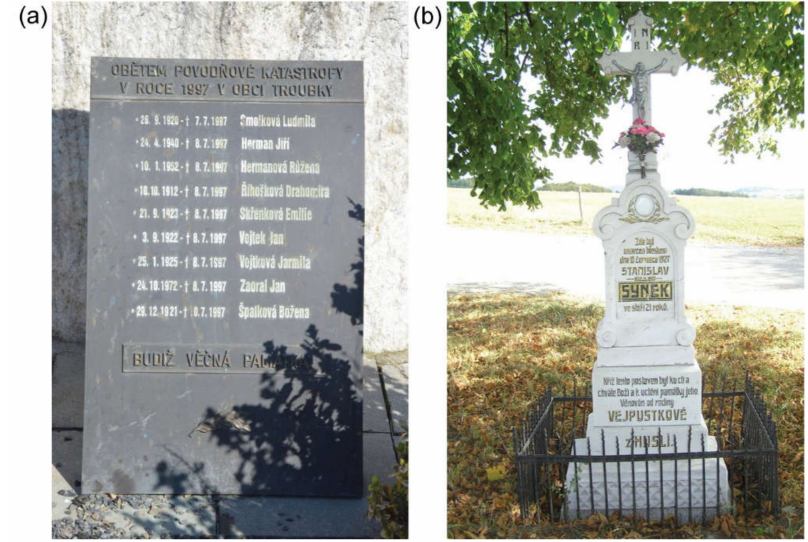
Figure 3. Examples of epigraphic evidence: ( a ) a list of victims of the July 1997 flood on the memorial at Troubky [63]; ( b ) report on the death of Stanislav Synek by lightning strike on a crest in the road near Jilmov í